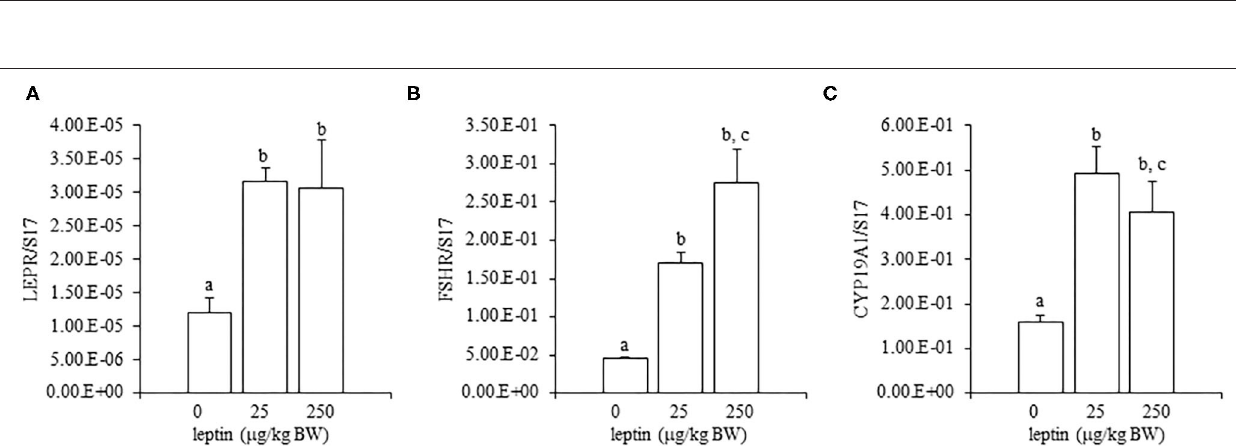
FIGURE 2 | Ovarian mRNA expression of LEPR (A) , FSHR (B) , and CYP19A1 (C) at 24h after leptin treatment in the 7-day-old chicks. Chicks were injected intraperitoneally (i.p.) with 0, 25, and 250 µ g/kg body weight (BW) of recombinant mouse leptin (rmleptin). The data represent the mean ± SEM ( n = 4), and bars with different superscripts are significantly